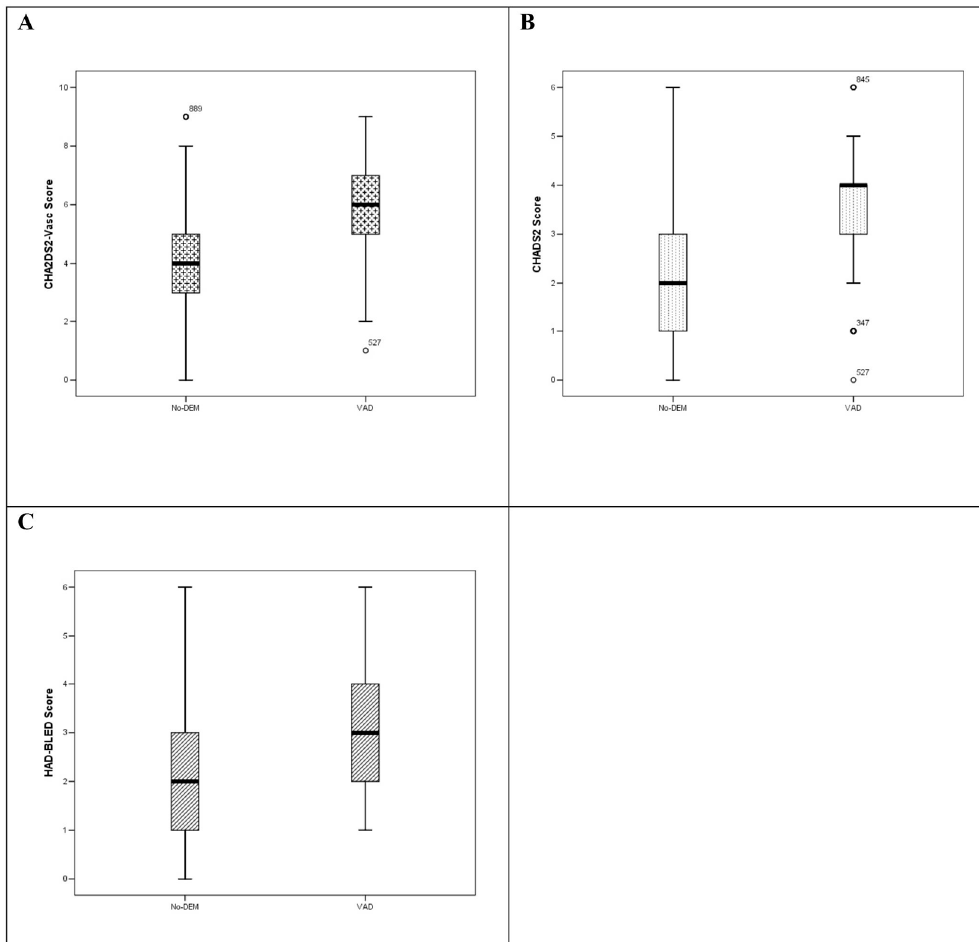
Figure 1. Differences in vascular risk scores between No-DEM and VAD. ( A ) CHA 2 DS 2 -VASc score was significantly lower in No-DEM than in VAD patients; ( B ) CHADS 2 score was significantly lower in No-DEM than in VAD patients; ( C ) HAS-BLED score was significantly higher in patients with VAD than in No-DEM subjects.